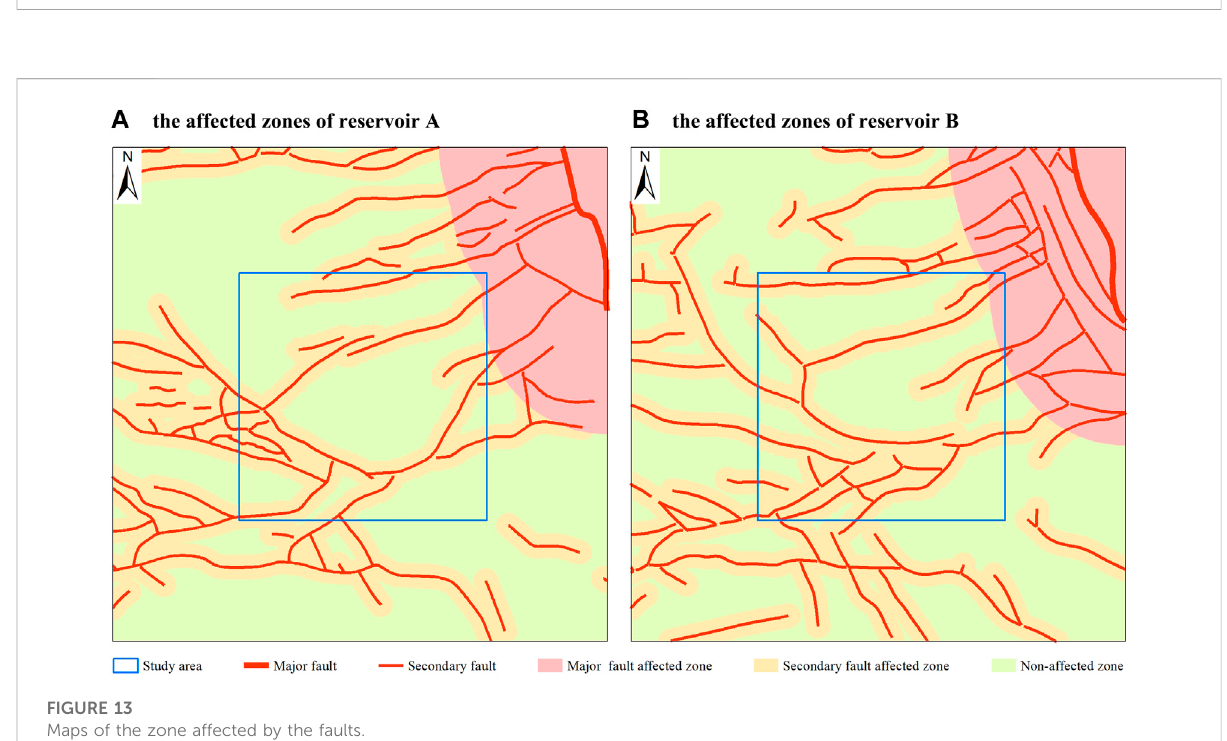
FIGURE 13 Maps of the zone affected by the